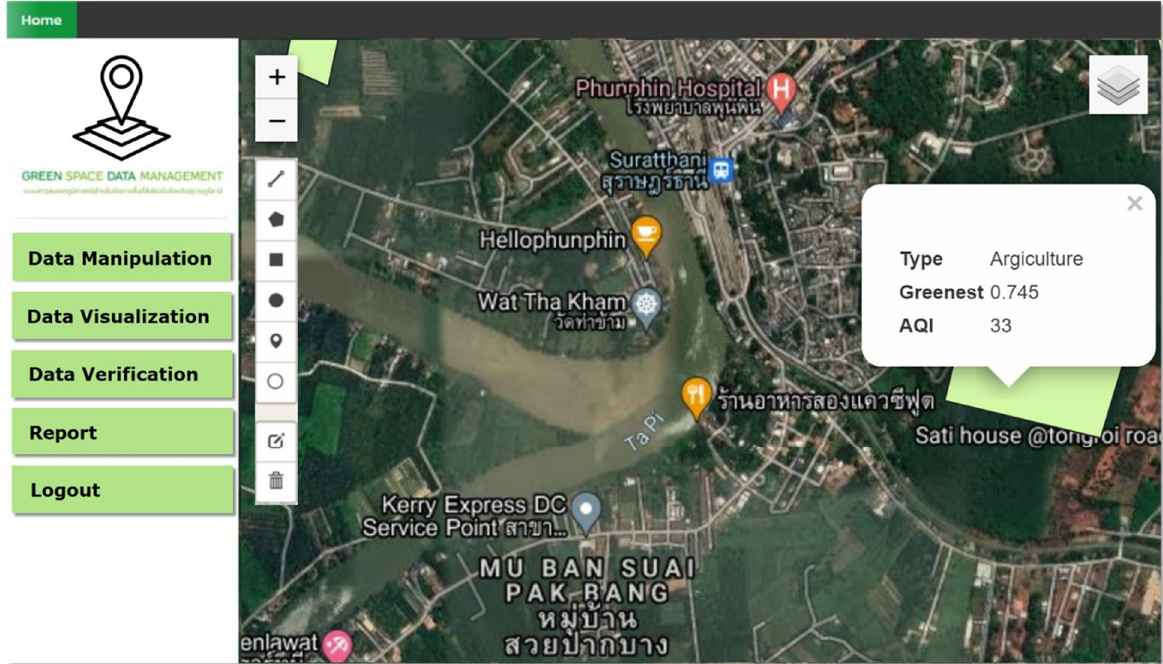
Figure 7. Web-based interface of the main page.